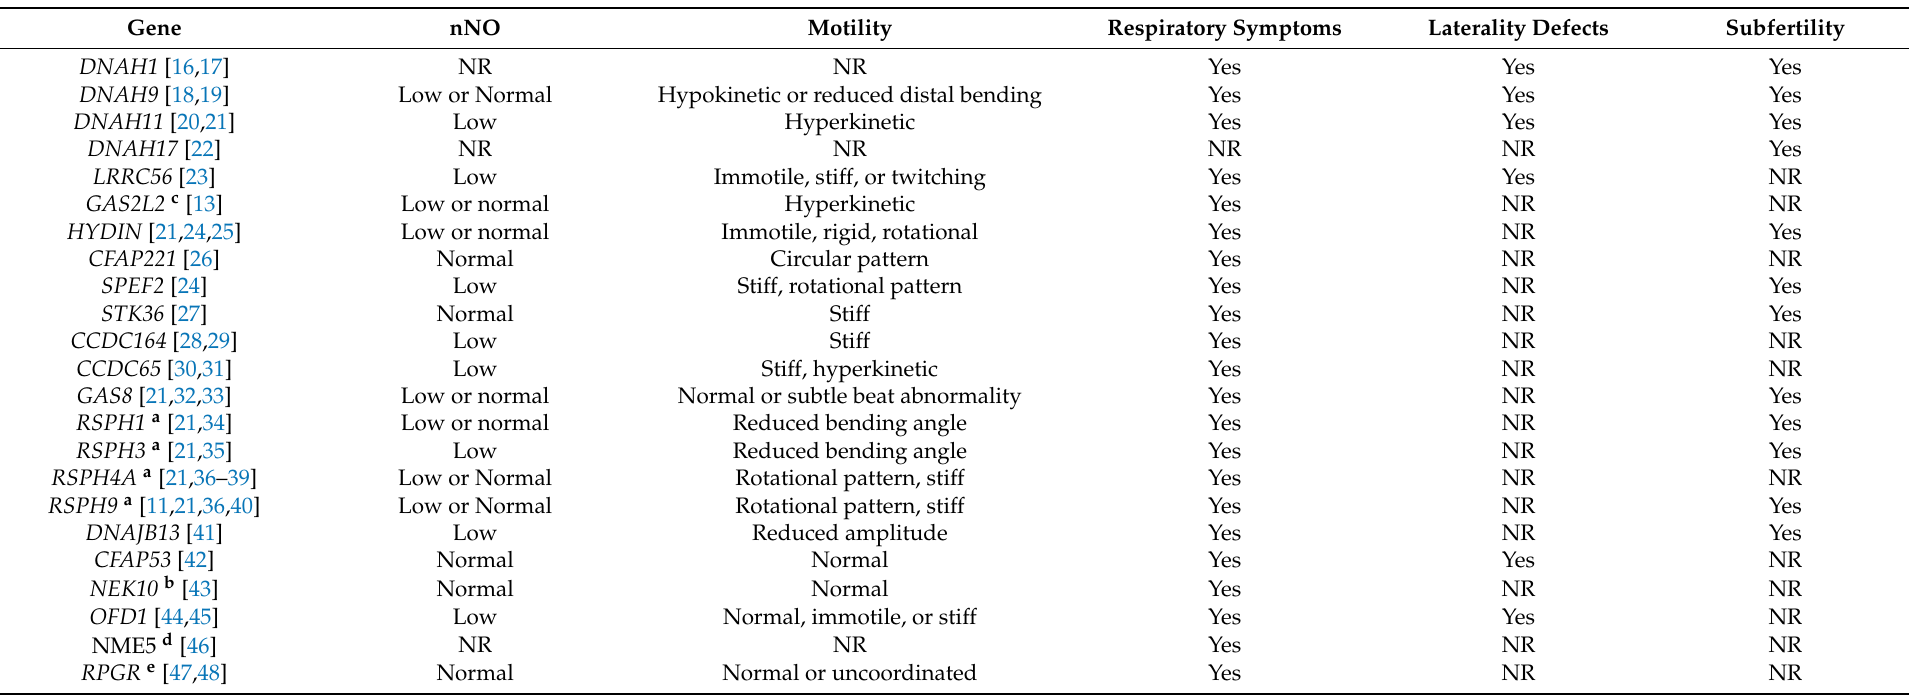
Table 1. Genes, clinical features, and diagnostic measures described in people with primary ciliary dyskinesia and normal or near-normal ciliary ultrastructure. Gene nNO Motility Respiratory Symptoms Laterality Defects Subfertility DNAH1 [16,17] NR NR Yes Yes Yes DNAH9 [18,19] Low or Normal Hypokinetic or reduced distal bending Yes Yes Yes DNAH11 [20,21] Low Hyperkinetic